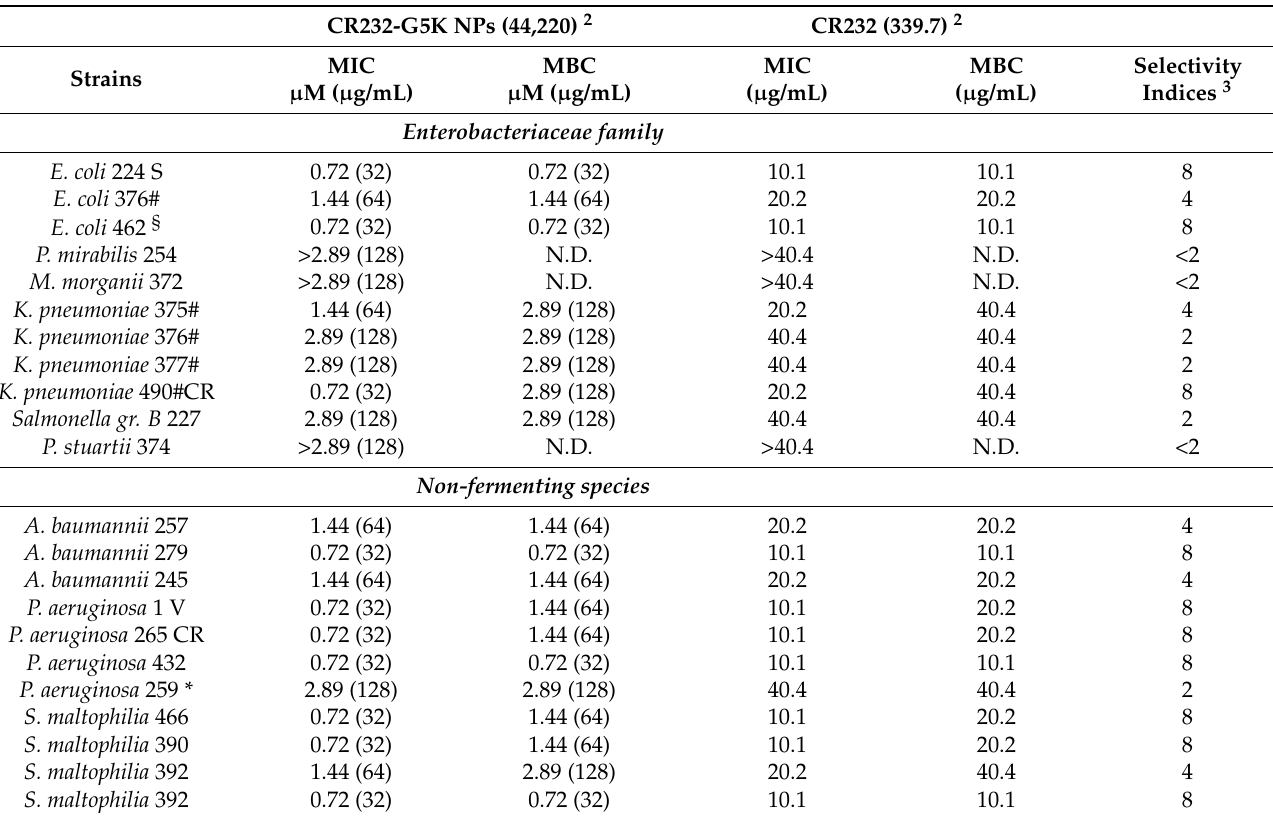
Table 3. MICs and MBCs of CR232-G5K NPs against bacteria of Gram-negative species, obtained from experiments carried out in triplicate 1 , expressed as µ M and µ g/mL, and those of CR232 released according to the drug loading and the release profile of CR232-G5K NPs [20], expressed as µ